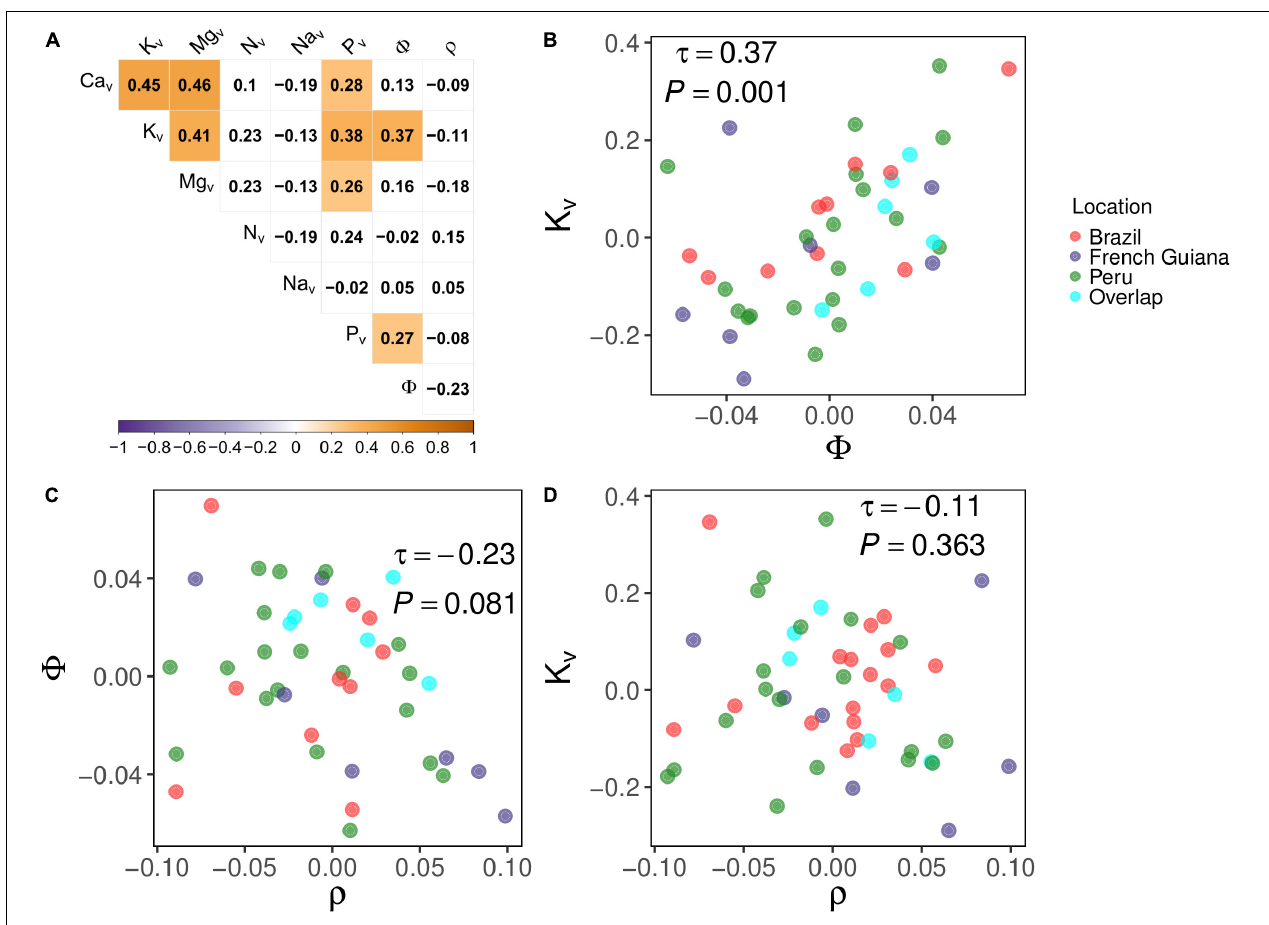
FIGURE 7 | (A) Correlation matrix between species effects (Equation 5) as given by Kendall’s τ with P- values adjusted as per Benjamini and Hochberg (1995). Subscript “v” indicates that concentrations are on a volume basis. (cid:56) , volumetric wood water content; ρ , wood density. (B) Relationship between species effects of (cid:56) and K v (Equation 5). (C) Relationship between species effects of (cid:56) and ρ . (D) Relationship between species effects of ρ and K v . Cyan circles in panels (A–C) depict species that occur in more than one